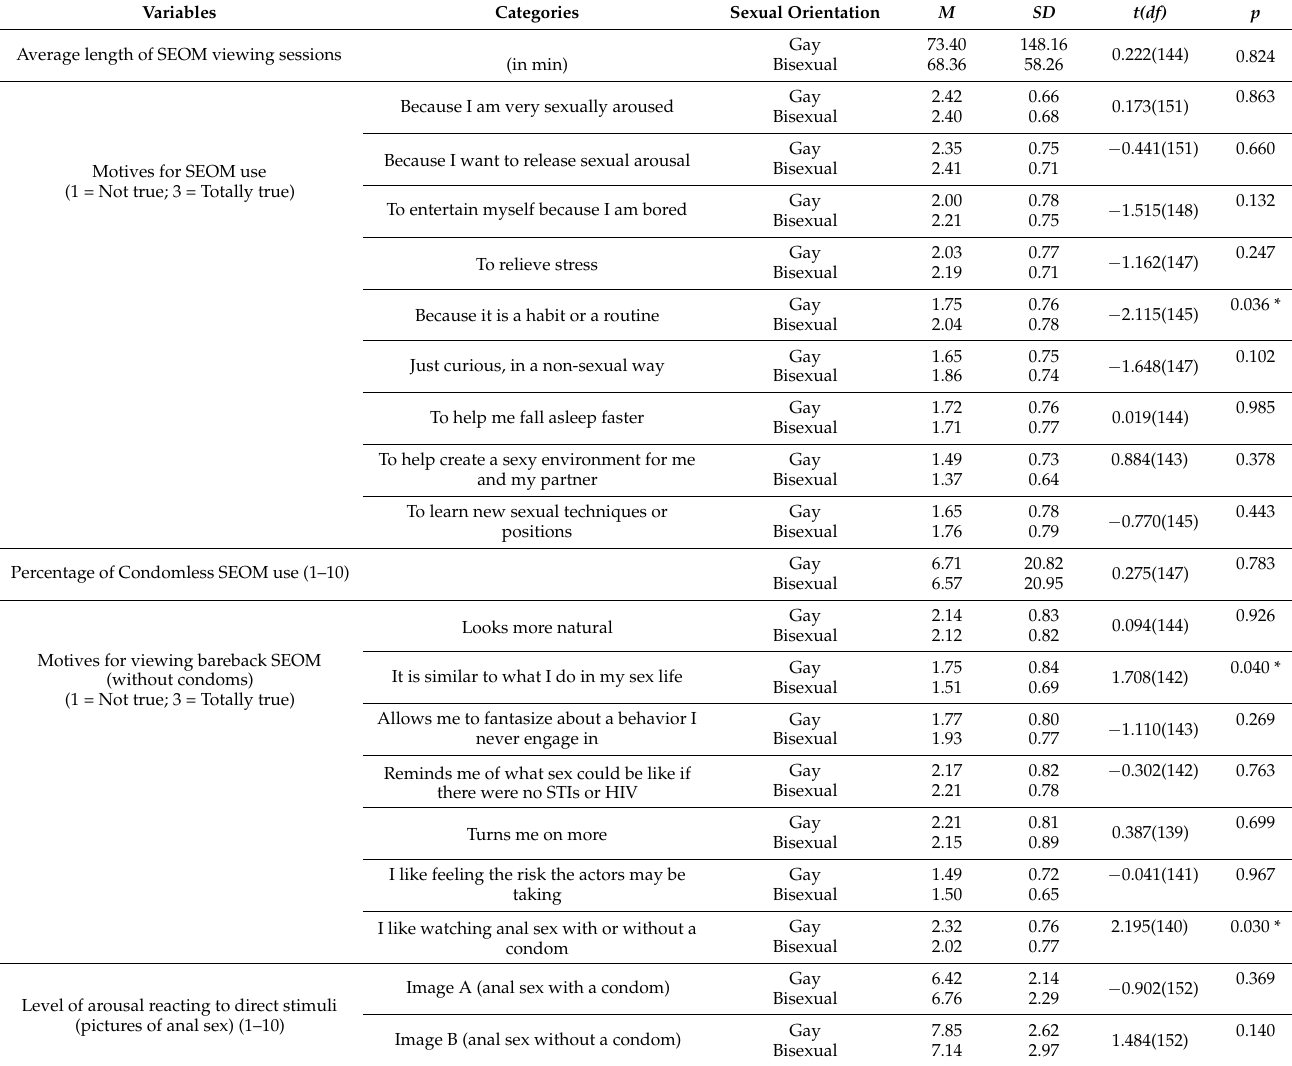
Table 3 describes SEOM use by sexual orientation. Regarding the activities that participants engaged in after viewing SEOM, 84.1% of participants mentioned masturbation. (82.9%) claimed that videos were their primary source of SEOM. Furthermore, 47.4% of all participants said that they had no preference for SEOM depicting safe or unsafe sex. Table 3. SEOM Use by Sexual